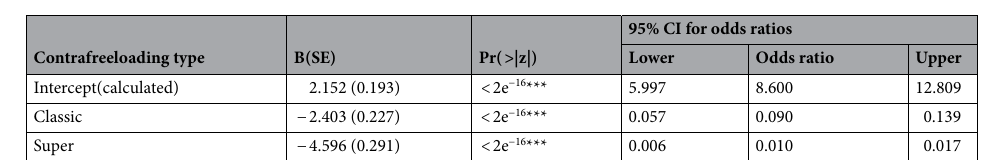
Table 3. Logistic regression model for contrafreeloading choices for the three trial types (calculated, classic, and super contrafreeloading). *** p < 0.001.